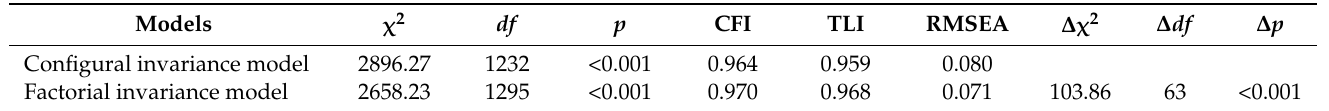
Table 5. Robust goodness-of-fit indices with modified 6-factor models in 2 levels of invariance among 4